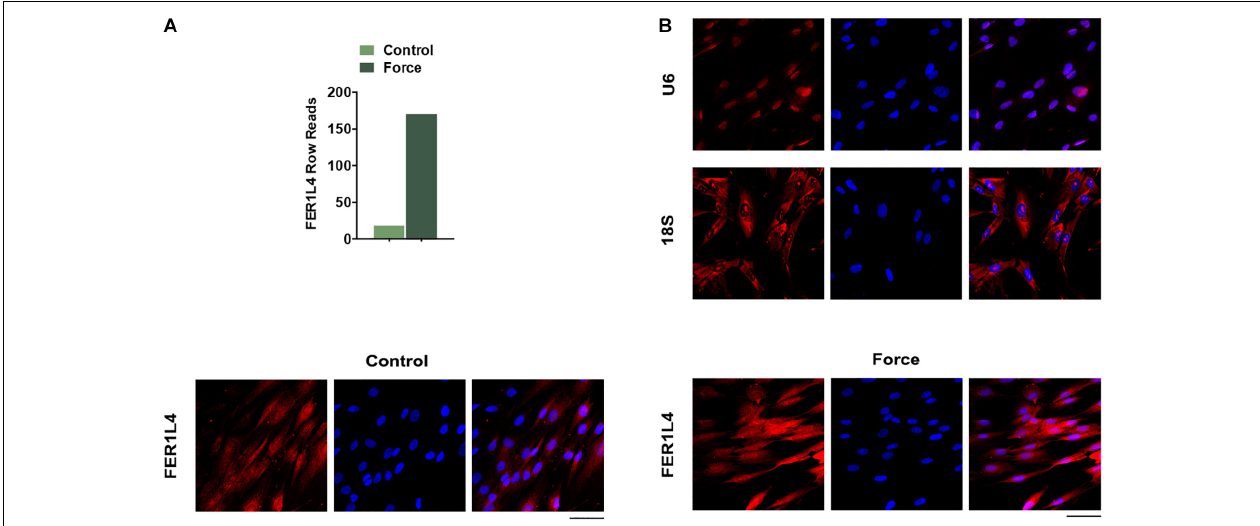
FIGURE 2 | FER1L4 was upregulated after the application of compressive force in PDLSCs. (A) Relative expression of FER1L4 determined by RNA sequencing after 12 h compression of PDLSCs. (B) FISH images of U6, 18S, and FER1L4. Scale bar: 50 µ m ( n =